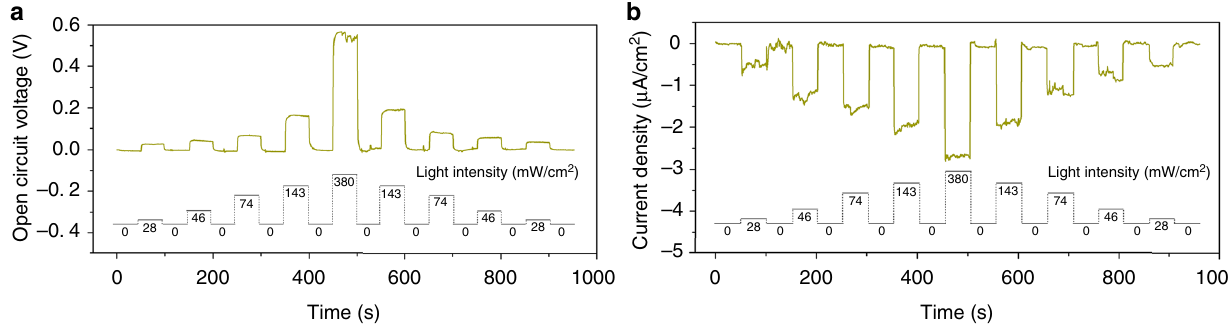
Fig. 5 Light intensity dependent photovoltage and photocurrent. a , b Photo-induced voltage ( a ) and ionic current ( b ) as a function of the light intensity from 0 to 380 mW/cm 2 . Each illumination process continues 50